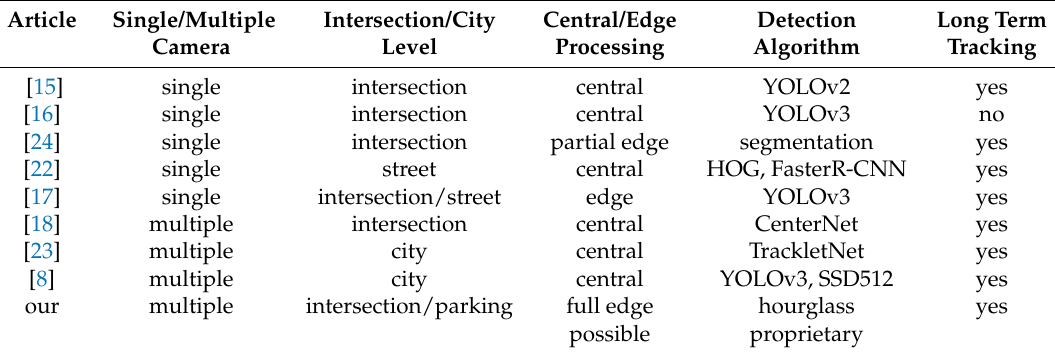
Table 1. Comparison of different approaches to vehicle